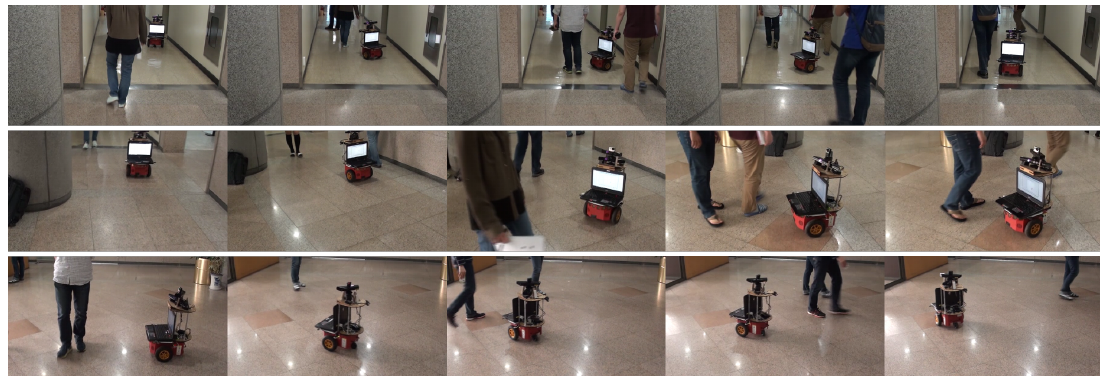
Figure 11. Snapshots from a real autonomous robot navigation experiment using the proposed motion model and motion controller in an L-shape lobby.